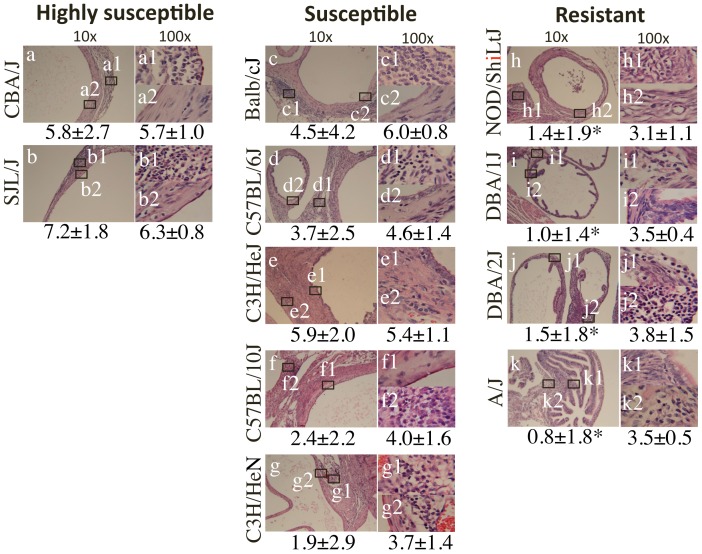
Hydrosalpinx examined under microscopy.The same genital tract tissues described in Fig. 1 legend were subjected to sectioning for H&E staining and microscopic observation. Both lumenal dilation and inflammatory infiltration were scored for oviduct tissues. Representative images from each group of mice taken under 10× (left columns, panels a–k) and 100× (right column, panels a1-k2) objective lens respectively are shown. The rectangles in each 10× image indicate where the two 100× images shown on the right were taken. Both the oviduct lumenal dilation (left) and inflammatory infiltration (right) scores (mean plus/minus standard deviation) from each group are listed under the corresponding images. Note that the lumenal dilation scores were significantly lower in the resistant strains (panels h–k) than highly susceptible (a & b) and 3 of 5 susceptible strains of mice (c–e). *p<0.05